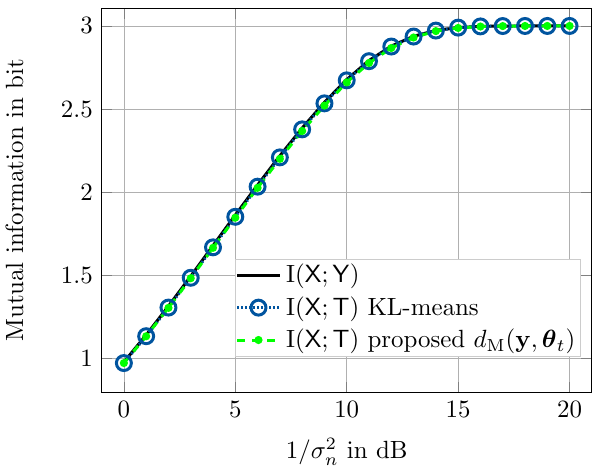
Figure 8. Comparison of KL-means and genetic algorithm optimized quantization using approximate nearest neighbor search from Section 3.1.3 for as an ultimate upper